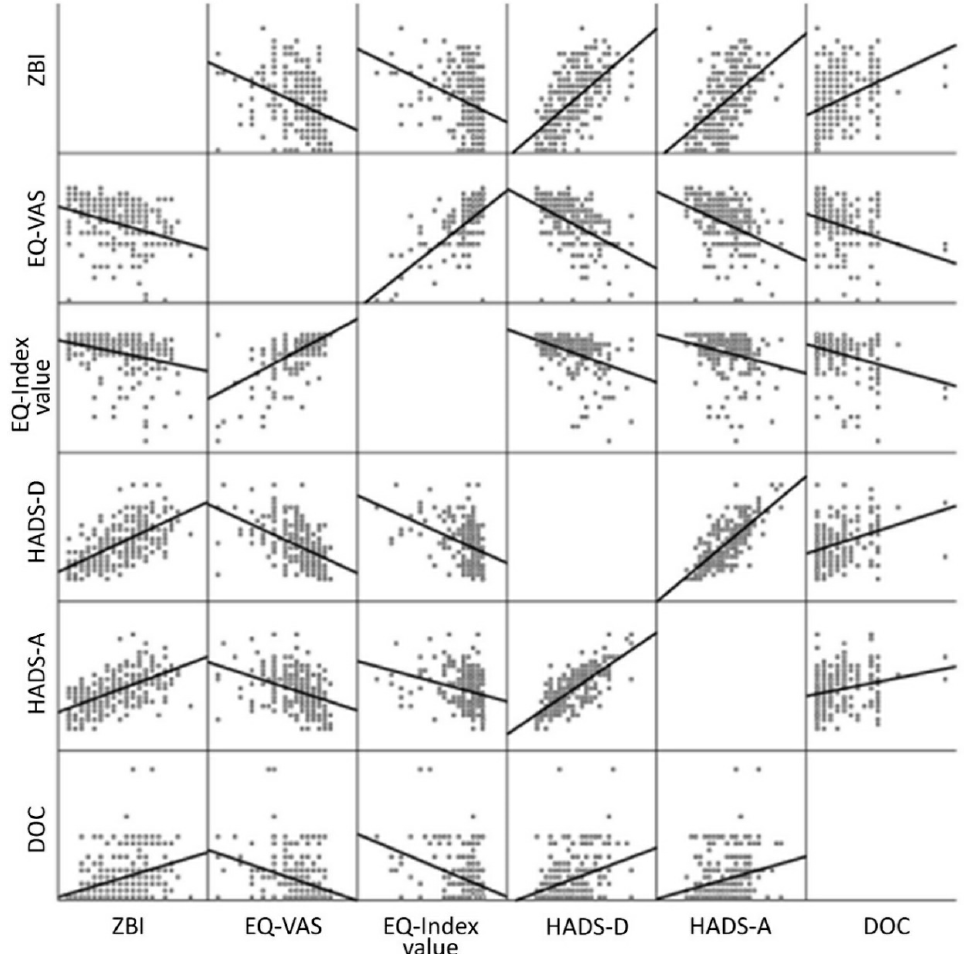
Figure 6. Correlation of parameters : Statistically significant correlations: ZBI ‐ DOC (r p = 0.379, p < 0.001, n = 242); ZBI ‐ HADS ‐ D (r p = 0.627, p < 0.001, n = 234); ZBI ‐ HADS ‐ A (r p = 0.550, p < 0.001, n = 234); ZBI ‐ EQ ‐ VAS/EQ ‐ 5D ‐ 5L index value (r p